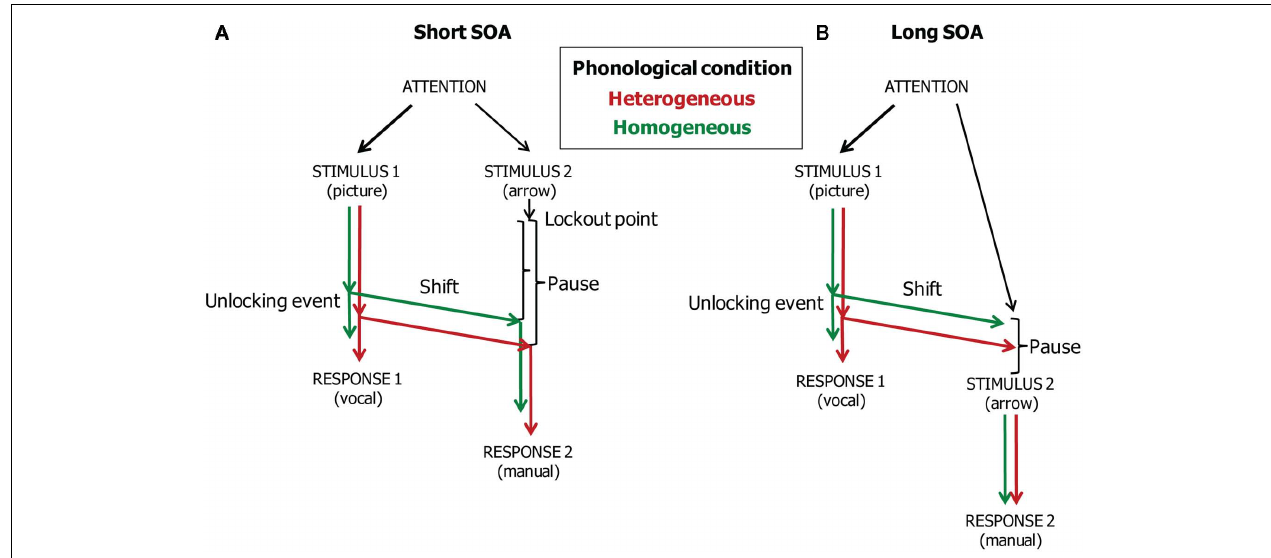
FIGURE 4 |Theoretical account of the time course of vocal responding (Task 1), attention and gaze shifting, and manual responding (Task 2) in the dual-task study of Roelofs (2008a). The stimulus onset asynchrony (SOA) is short (A) or long (B) .